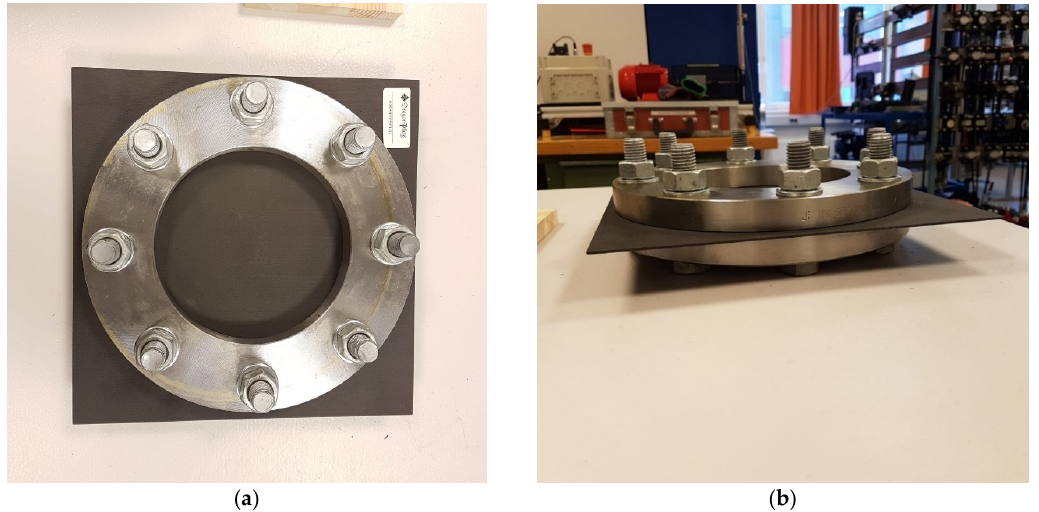
Figure 5. ( a ) The CFRP sample clamped in a circular flange with an inner diameter of 173 mm (top view). ( b ) The CFRP sample clamped in a circular flange (side view).